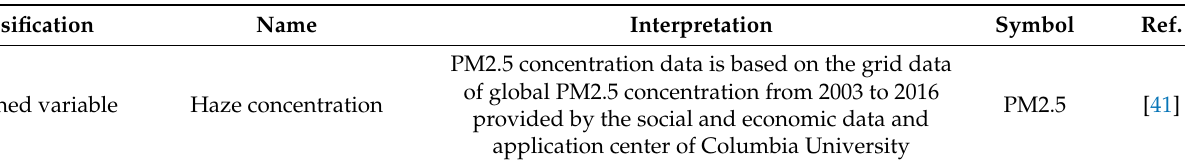
Table 2. Variable